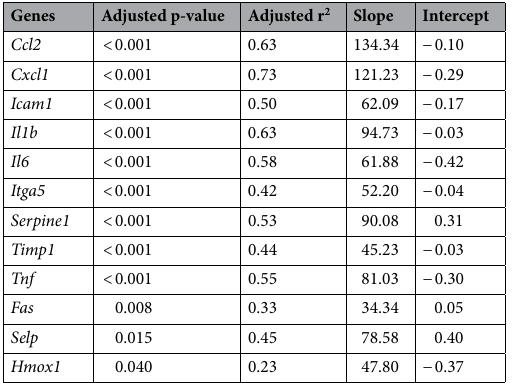
Table 4. Genes displaying significant correlations between relative expression and K trans across targets sonicated with Definity or BG8774 in circulation. Units of slope are log2 fold change in relative gene expression/min-1 (K trans of gadobutrol).